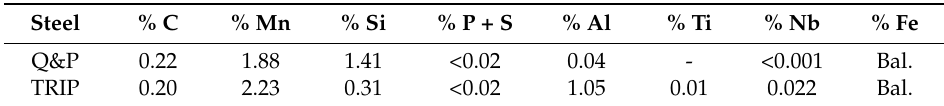
Table 1. Chemical composition (wt %) of quenching and partition (Q&P) and transformation induced plasticity (TRIP) steels, as measured by optical emission spectroscopy.